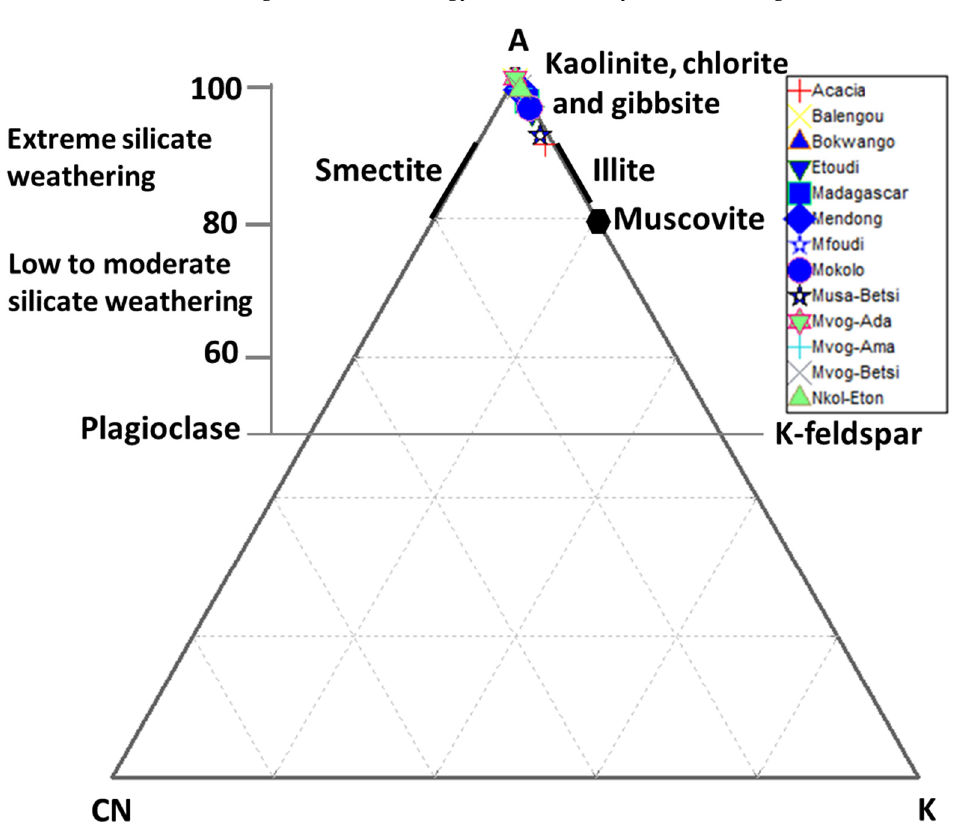
Figure 8. Ternary plot of A (Al 2 O 3 ) − CN (CaO* + Na 2 O) – K (K 2 O) combined with CIA.